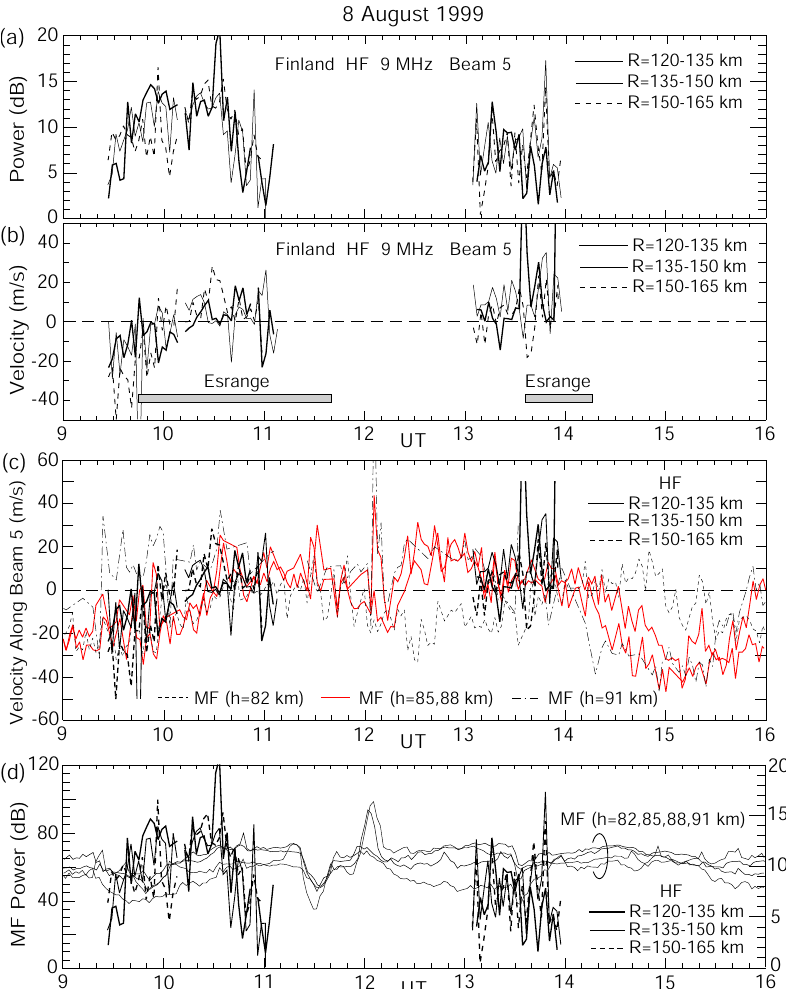
Fig. 2. Time variations of (a) echo power and (b) Doppler velocity observed at three range gates on beam 5 (looking toward Tromsø) of the Hankasalmi HF radar (9MHz) on 8 August 1999. (c) Time variations of neutral wind velocity (positive toward Hankasalmi) along HF radar beam 5 observed at four altitudes with the Tromsø MF radar, and of Doppler velocity at three range gates on beam 5 of the HF radar. (d) Time variations of echo power observed at four altitudes with the MF radar and at three range gates on beam 5 of the HF radar. Two PMSE occurrences detected with the Esrange radar are lightly shaded in